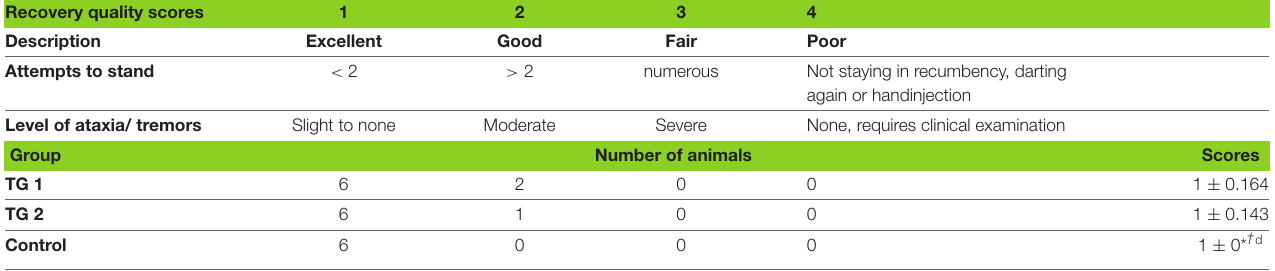
TABLE 4 | Distribution of scores representing the quality of recovery in TG a 1: ketamin–medetomidin–midazolam–butorphanol (KMMB), TG 2: tiletamine–zolazepam–medetomidin–butorphanol and CG b : etorphine–acepromazine–detomidin–butorphanol (EADB) immobilized kulans (Equus hemionus kulan). Recovery quality